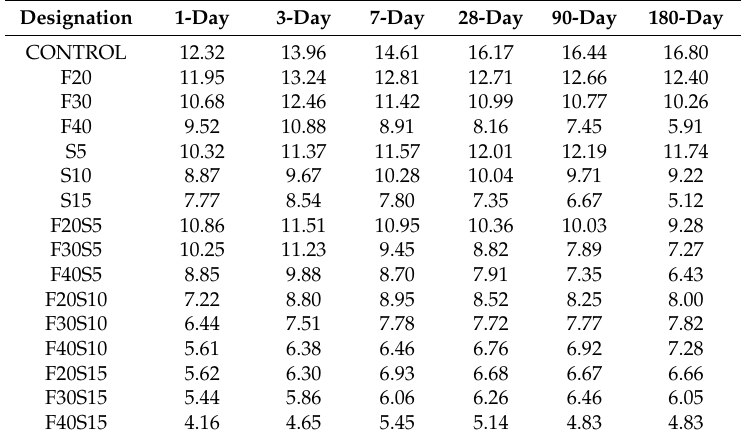
Table 2. Calcium hydroxide content (percentage) of binary and ternary cement pastes at various ages.